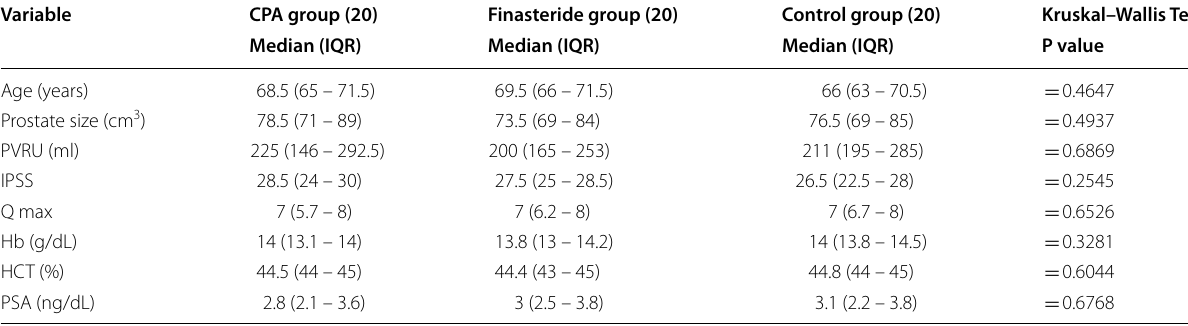
Table 1 Comparison between the 3 groups as regards pre‑operative data using Kruskal–Wallis test